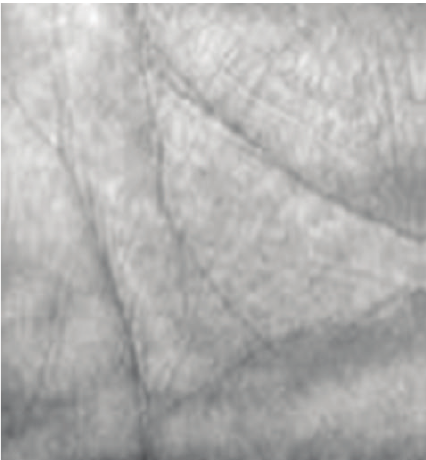
Figure 4: Effect of traditional adaptive median filtering